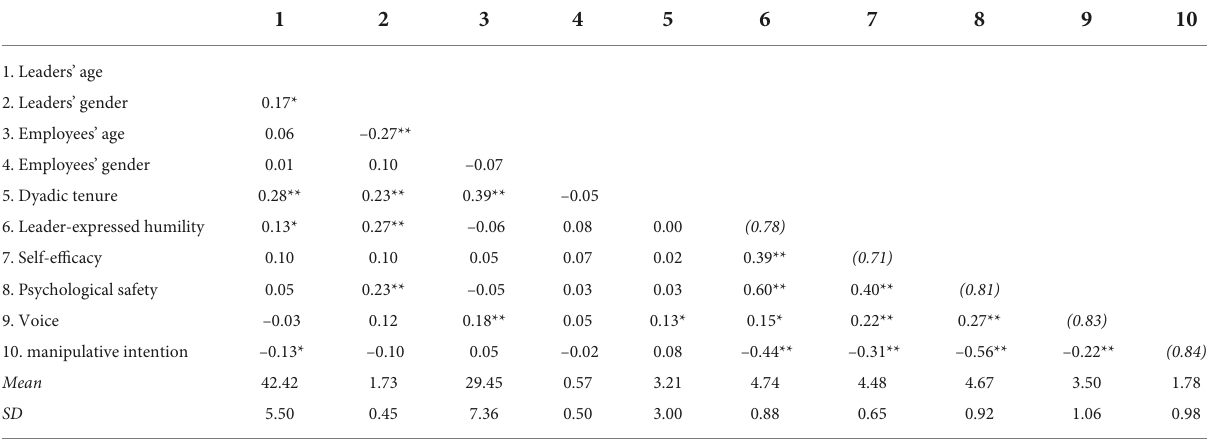
TABLE 3 Means, standard deviations and correlations ( N = 238).